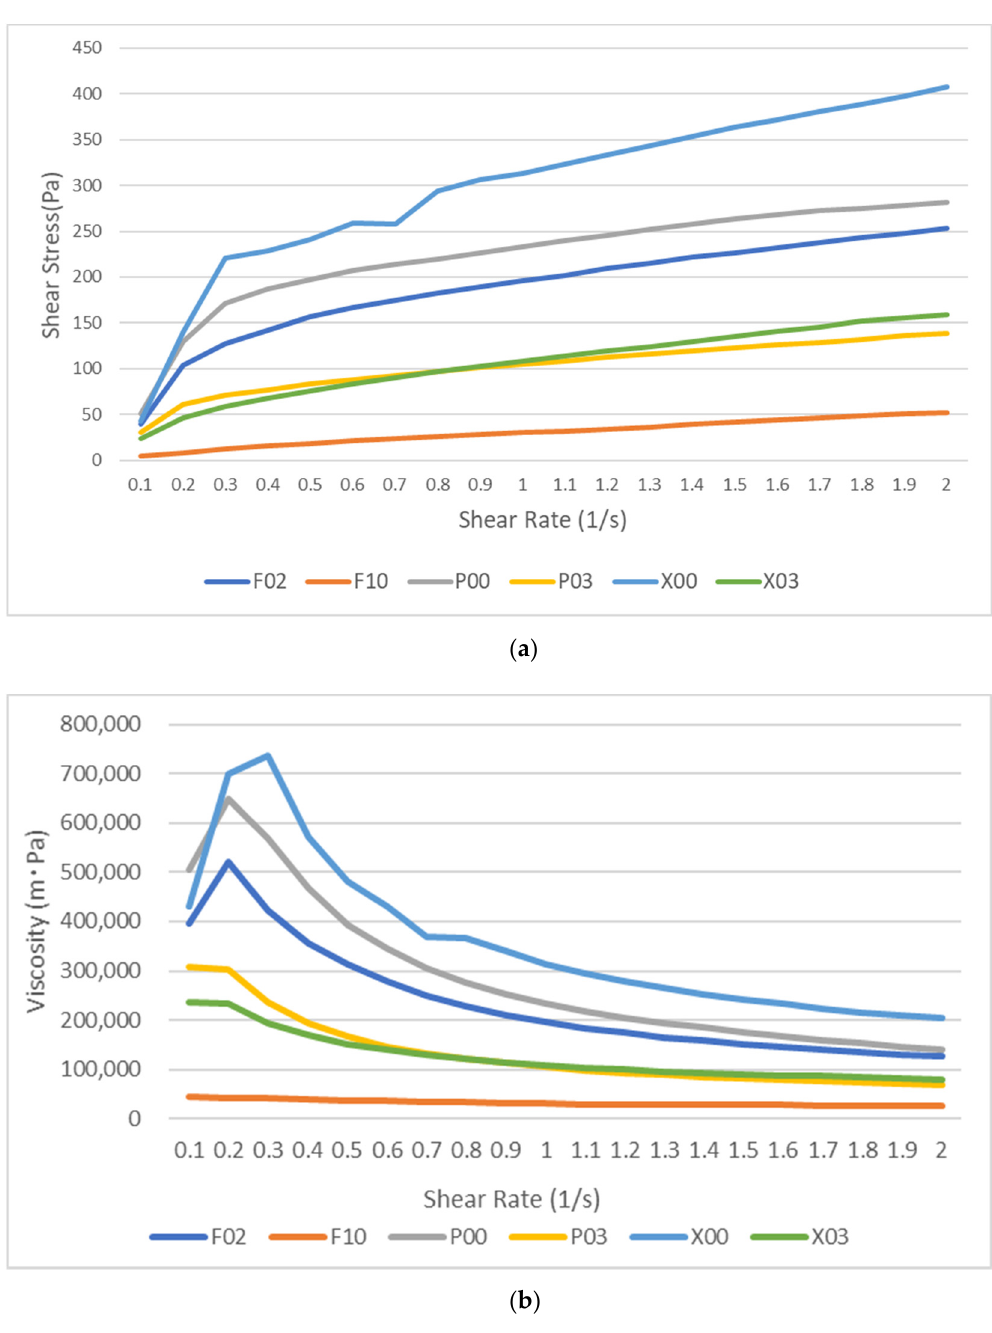
Figure 4. The average values of the shear stress ( a ) and viscosity ( b ) for each sample of flowable resin composite. The shear stress and viscosity values of all the flowable resins quickly increased on a curve until the shear rate of 1.0 s − 1 , whereas their increase became almost constant with a linear gradient after the shear rate of 1.0 s − 1 .